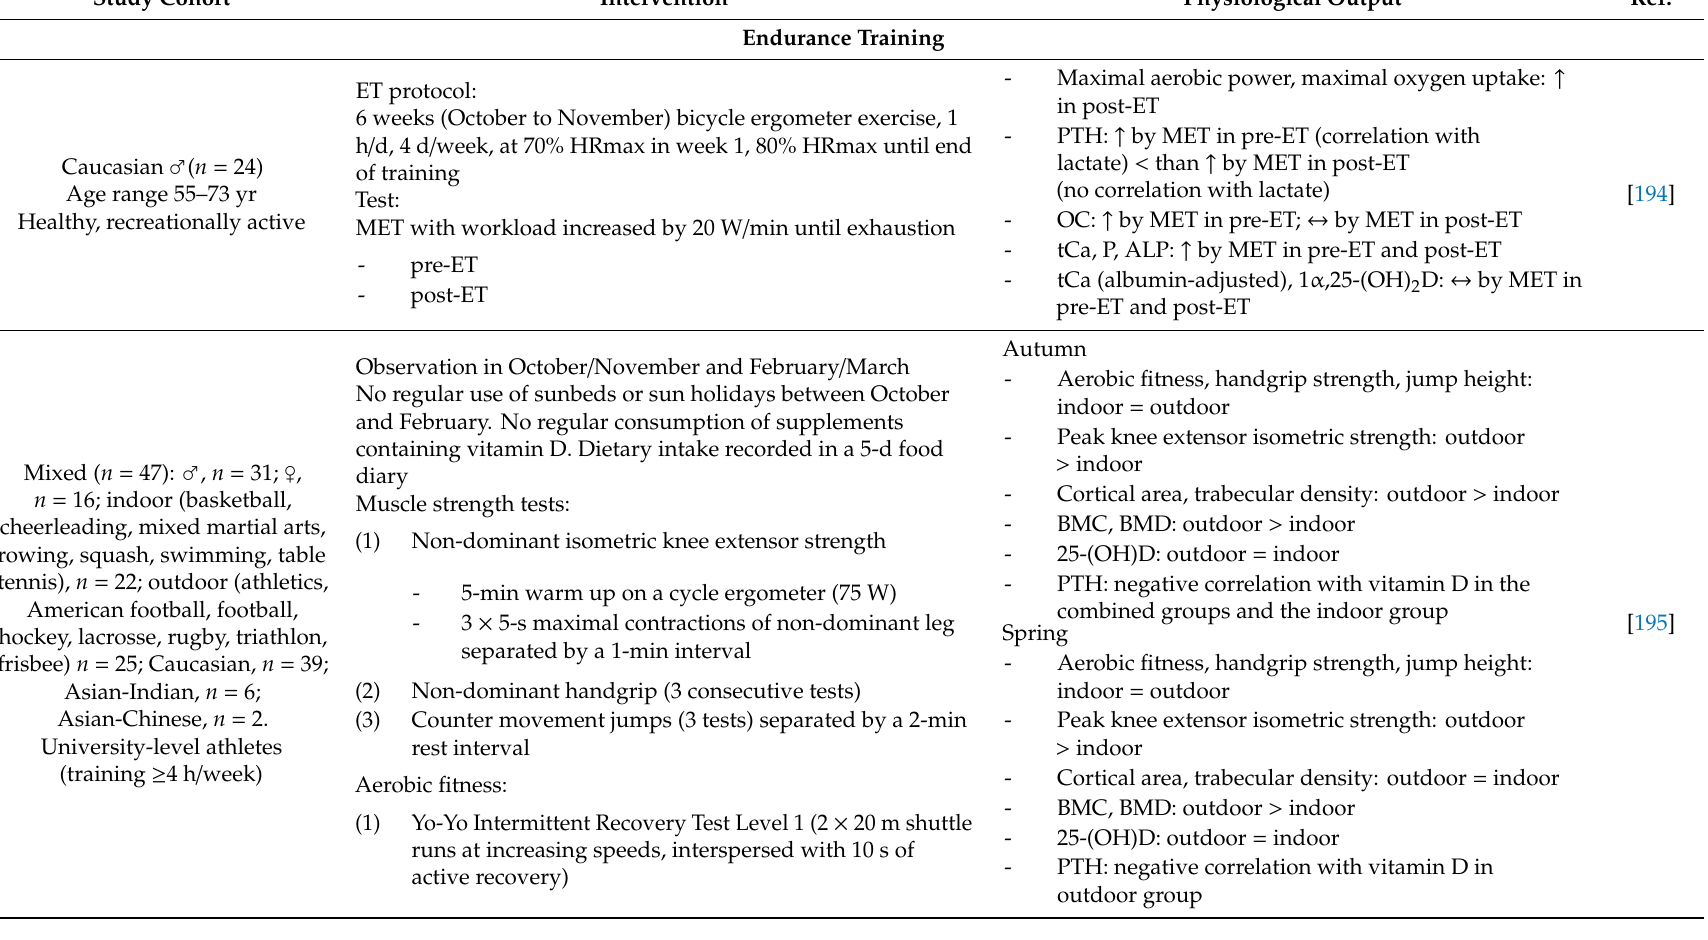
Table 4. Regulation of PTH secretion and PTH-dependent calcium-phosphate metabolism in relation to exercise training or training status in humans. Study Cohort Intervention Physiological Output Ref. Endurance Training